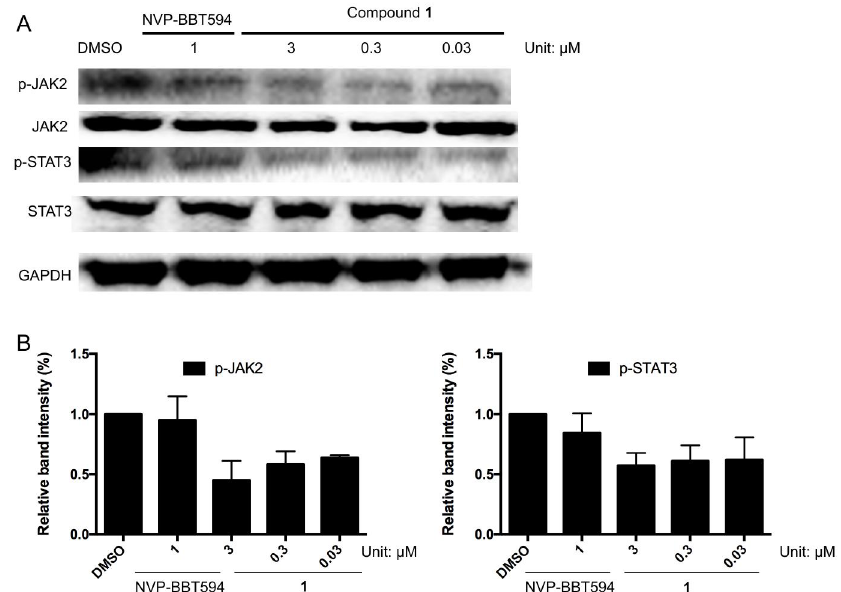
Fig 3. Compound 1 reduces phosphorylation of JAK2, STAT3 in A375 cells. A375 cells were treated with the indicatedconcentrations of compound 1 (0.03 to 3 μ M) or positive control compoundNVP-BBT594 (1 μ M) for 24 h. Protein lysates were analyzedby Western blotting with the indicatedantibodies.Error bars represent the standarddeviationof triplicate results.